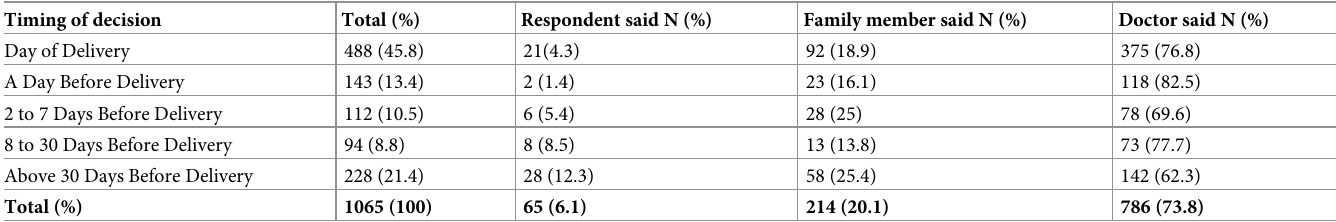
Table 3. Timing of decision for CS delivery by decision makers (N =